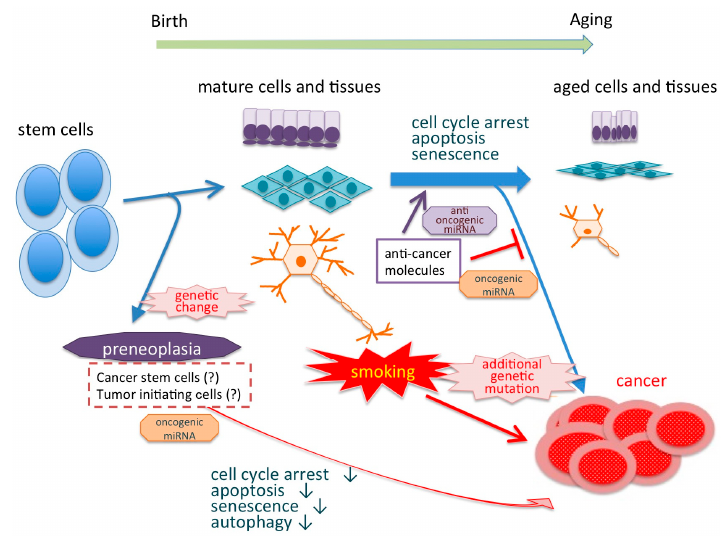
Figure 2. Life time from stem cells to aging and/or carcinogenesis. Genetic changes such as mutations induce carcinogenesis by suppressing the production of anticancer molecules via activating oncogenic miRNAs.